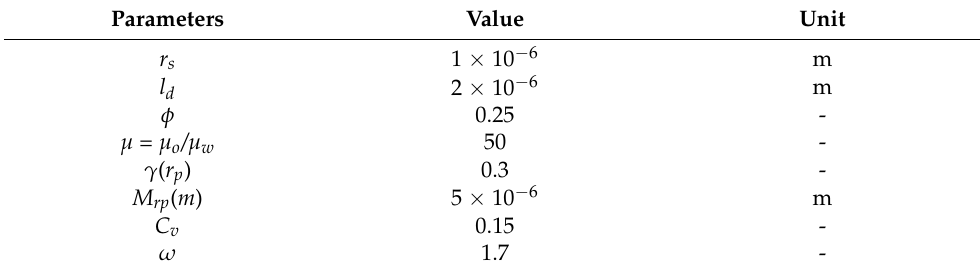
Figure 4. Dependence of the critical retention function on the connate water saturation. Table 1. Parameters used for calculations of σ cr ( U , S wi ).